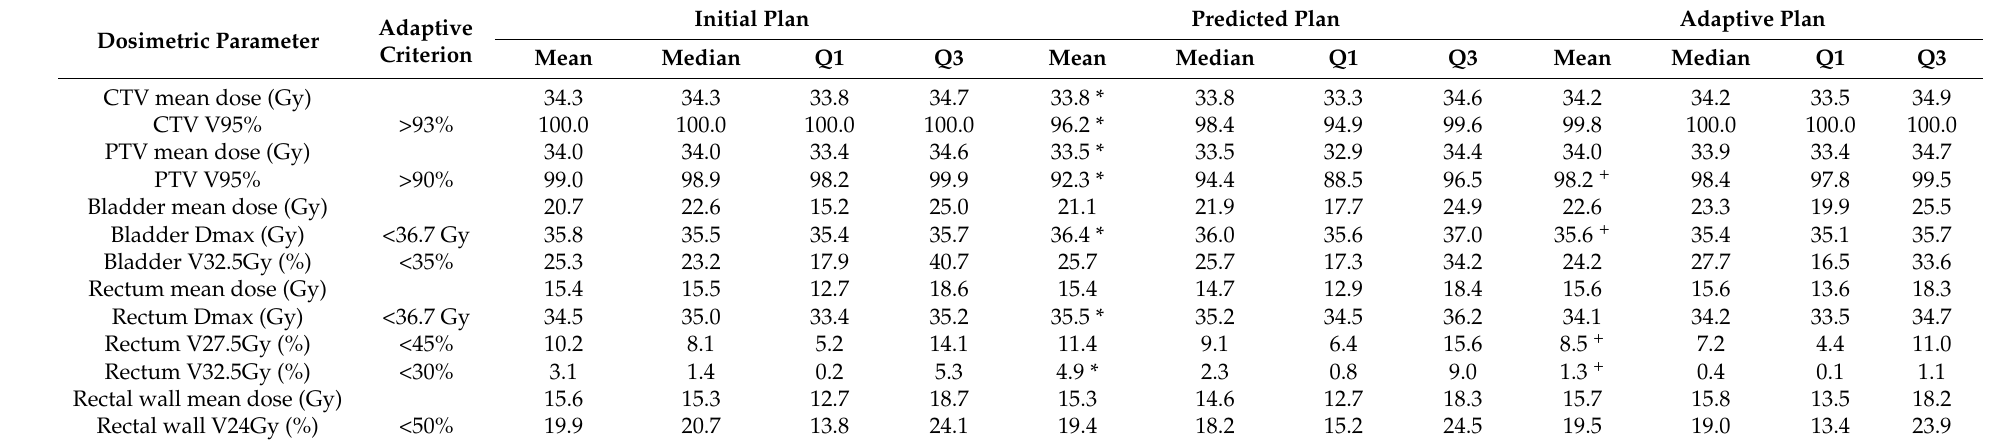
Table 2. Dosimetric metrics of initial plan, predicted dose on daily anatomy and adaptive